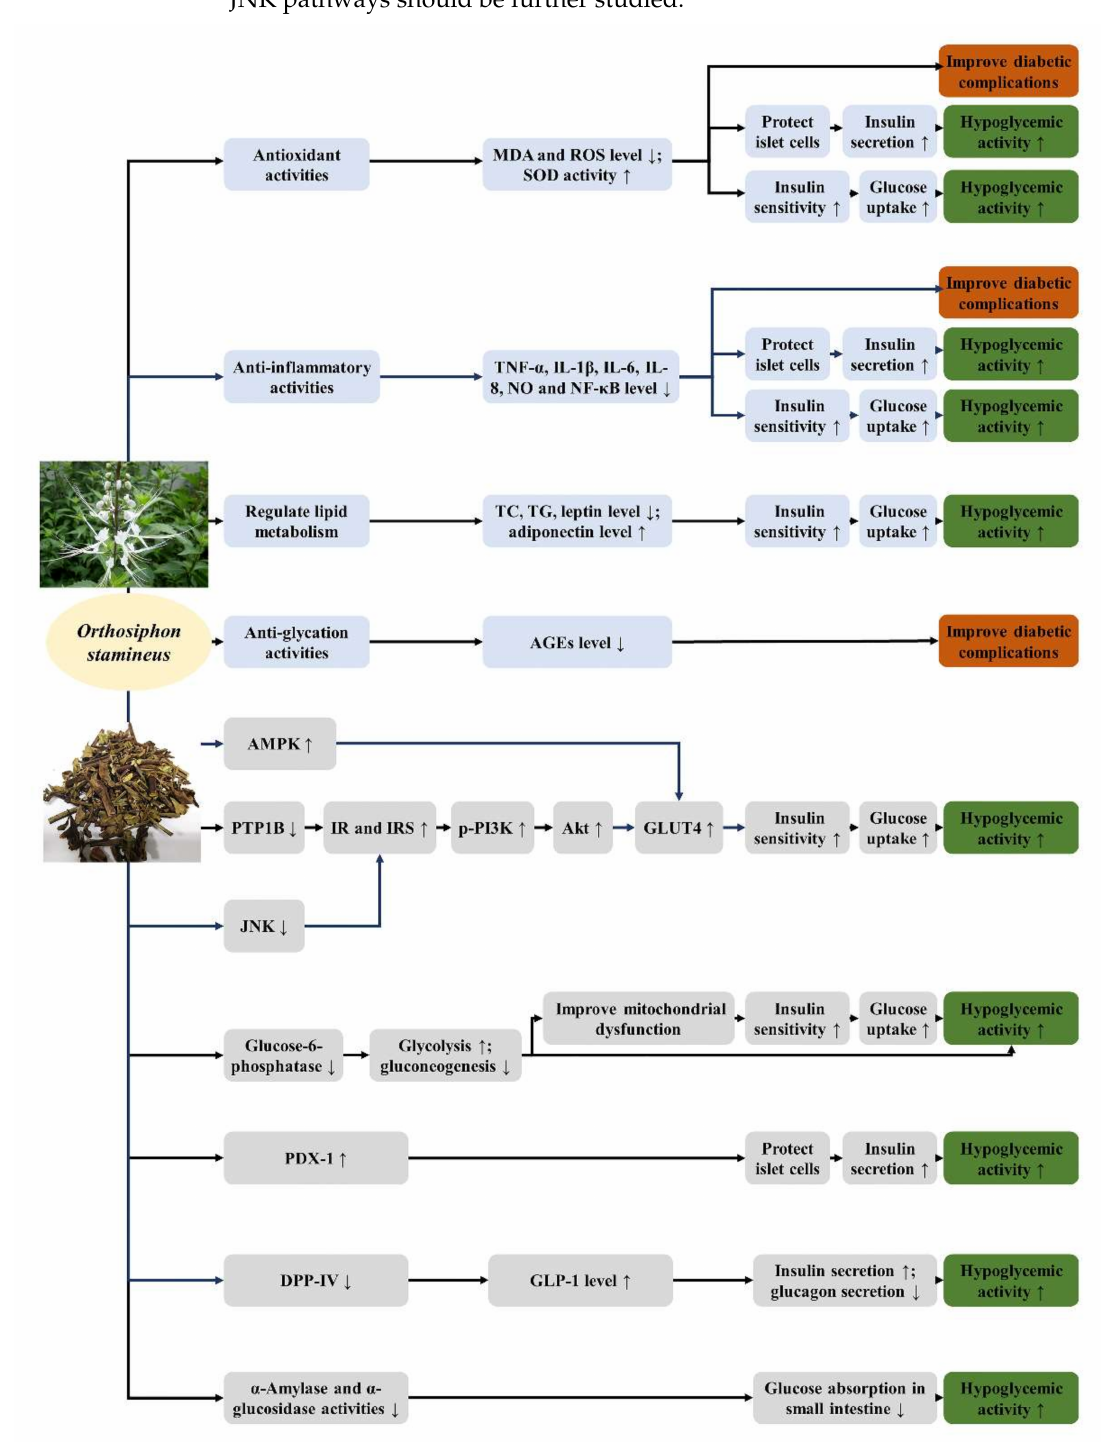
Figure 5. The mechanisms of O. stamineus in the treatment of diabetes and its complications. (The blue part shows other activities related to antidiabetic activity. The grey part is the pathways, targets, and enzymes related to antidiabetic